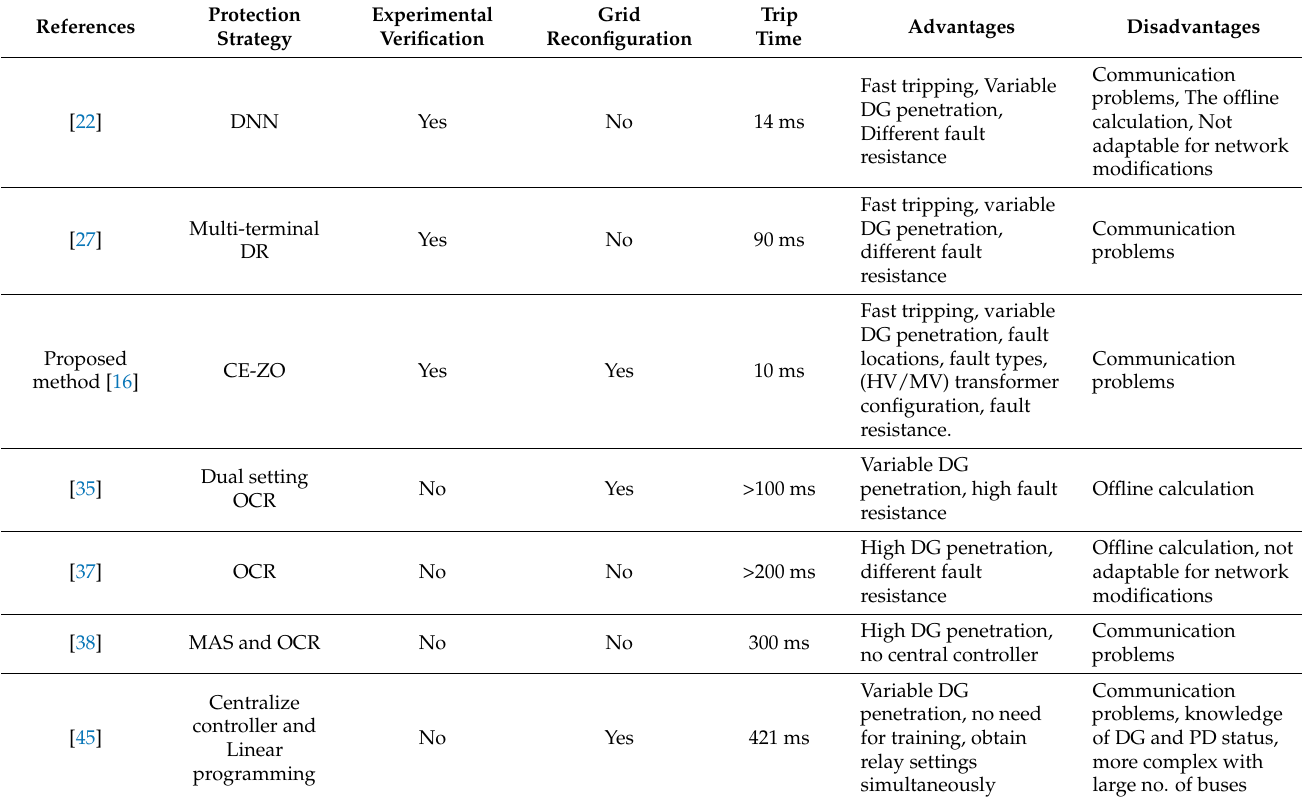
Table 5. Comparison of the proposed strategy among other topologies operating under similar